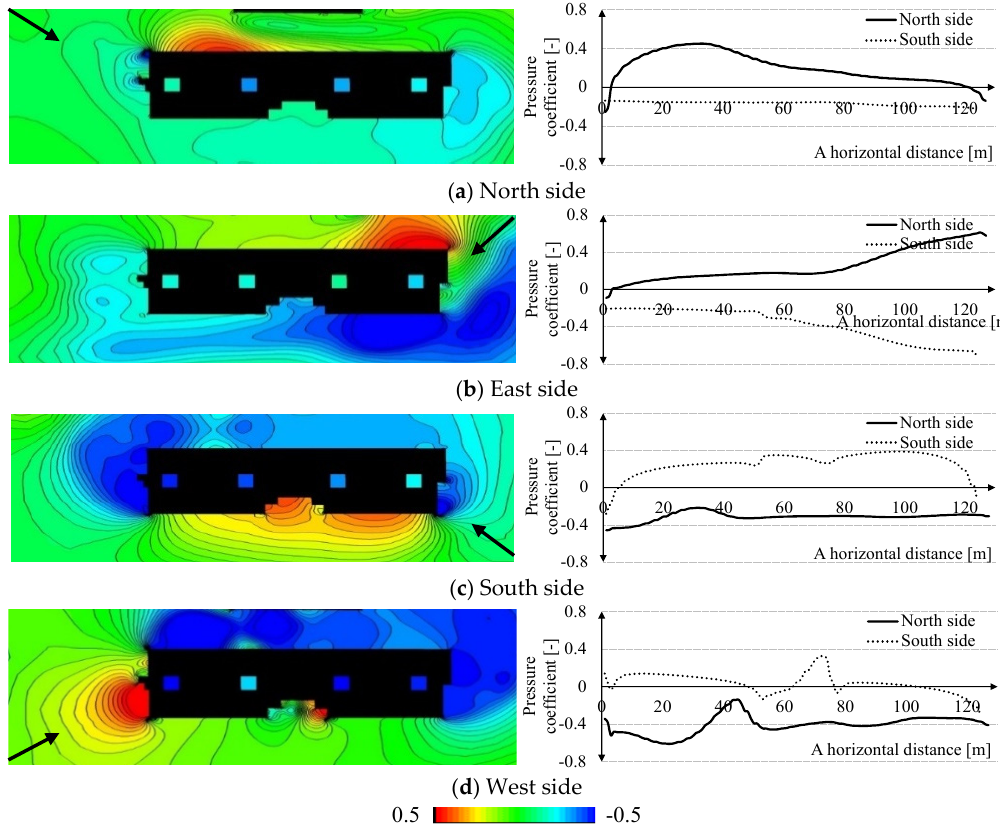
Figure 9. Description of the control strategies for natural ventilation: ( a ) north; ( b ) east; ( c ) south; and ( d ) west sides.